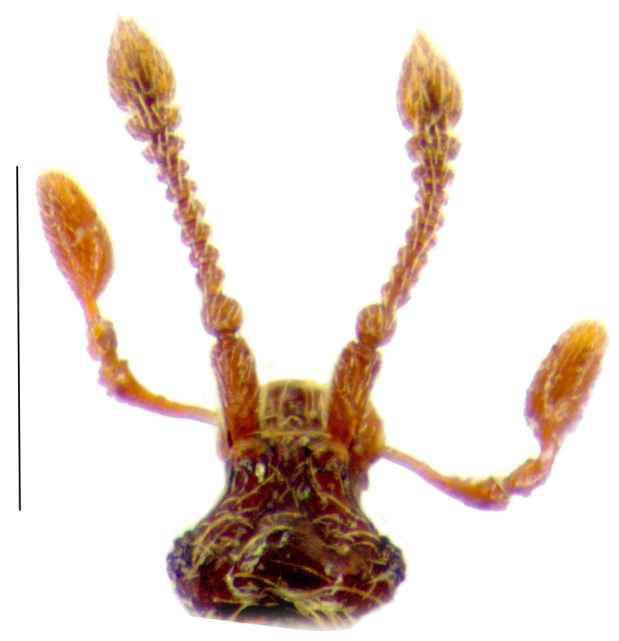
head, scale: 0.3 mm